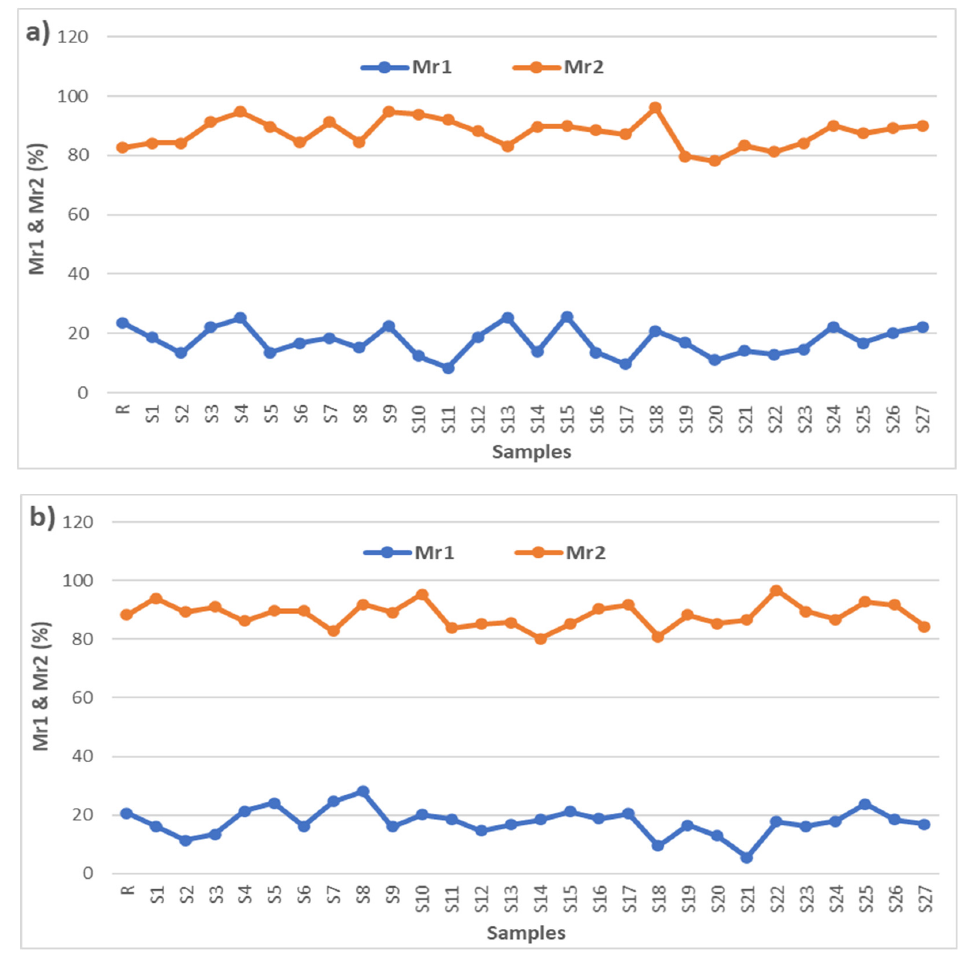
Figure 7. Material ratio assessment: ( a ) ABS material; ( b ) ASA material.